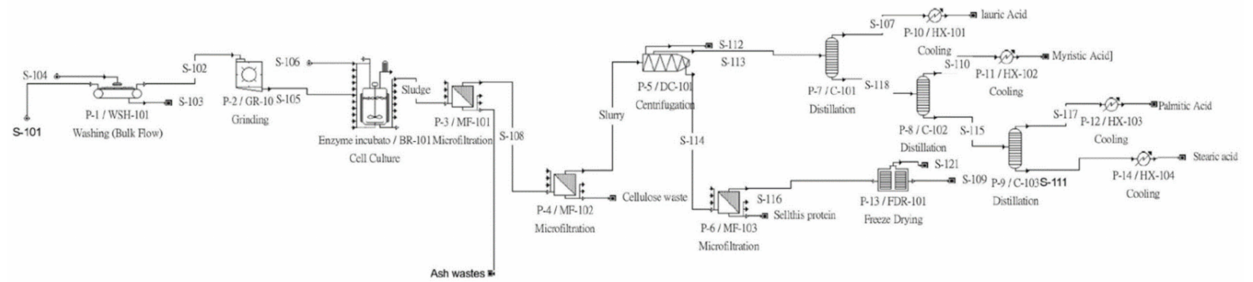
Figure 1. The factory schematics.